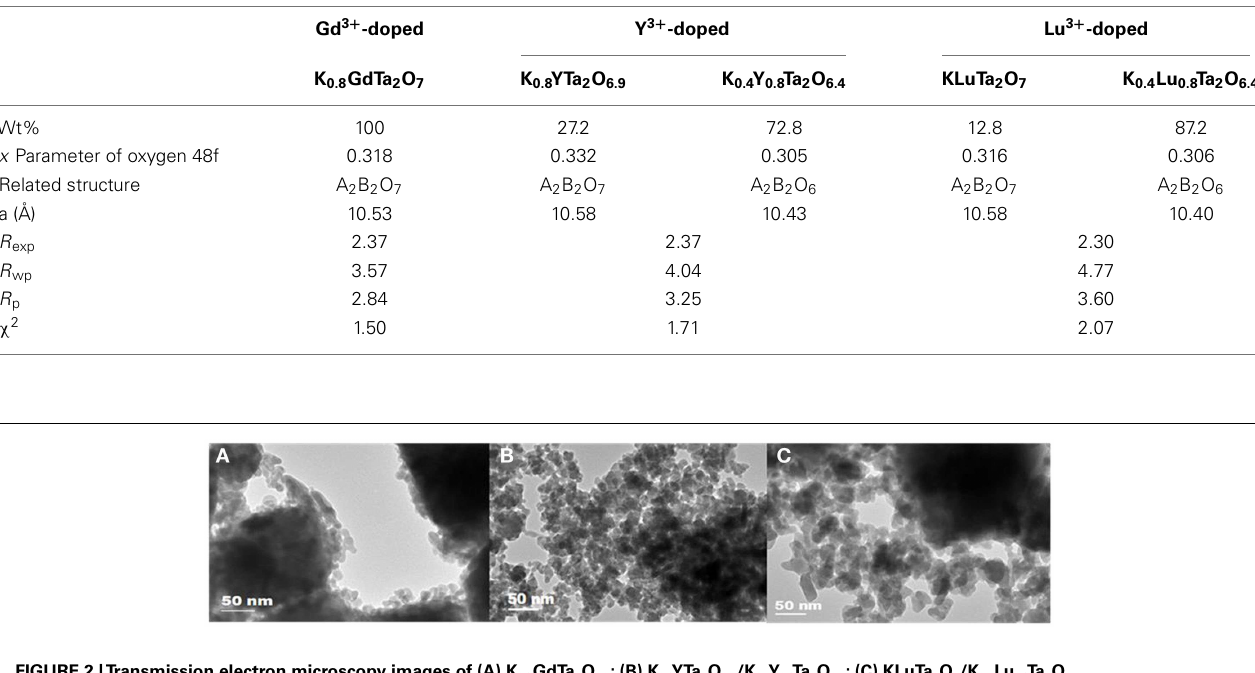
FIGURE 2 |Transmission electron microscopy images of (A) K 0.8 GdTa 2 O 6.9 ; (B) K 0.8 YTa 2 O 6.9 /K 0.4 Y 0.8 Ta 2 O 6.4 ; (C) KLuTa 2 O 7 /K 0.4 Lu 0.8 Ta 2 O 6.4 .